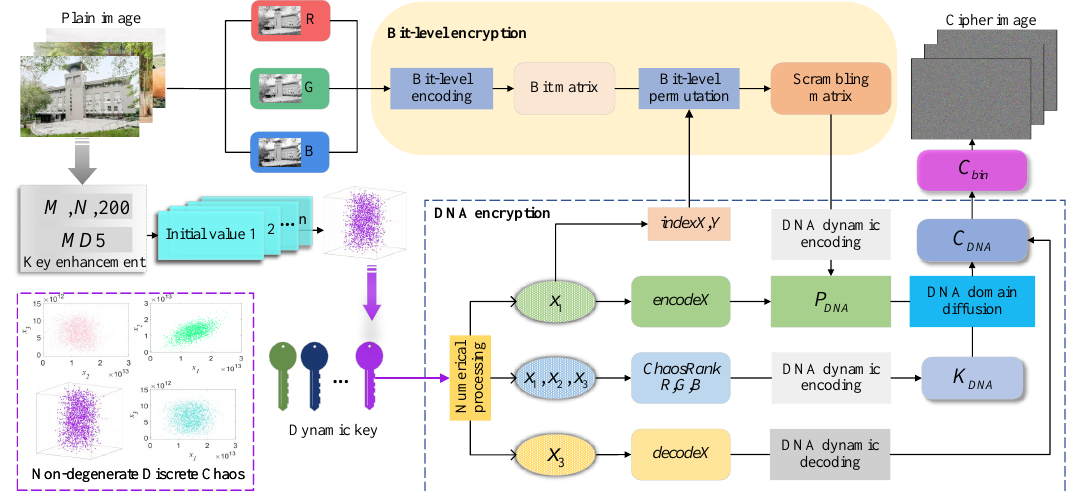
Figure 2. The block diagram of the encryption